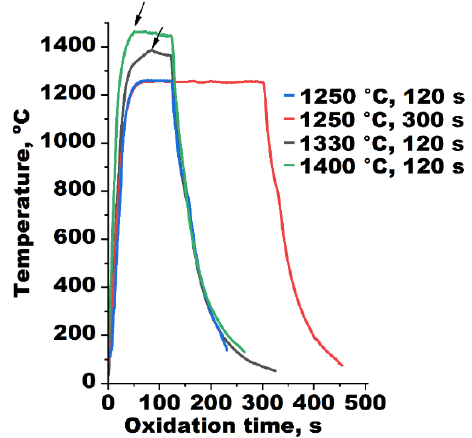
Figure 11. Temperature profiles of the samples during oxidation in water steam at 1250, 1330, and 1400 °C. 1400 ◦